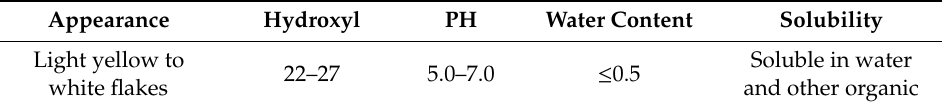
Table 4. The physical properties of polycarboxylic acid superplasticizer.